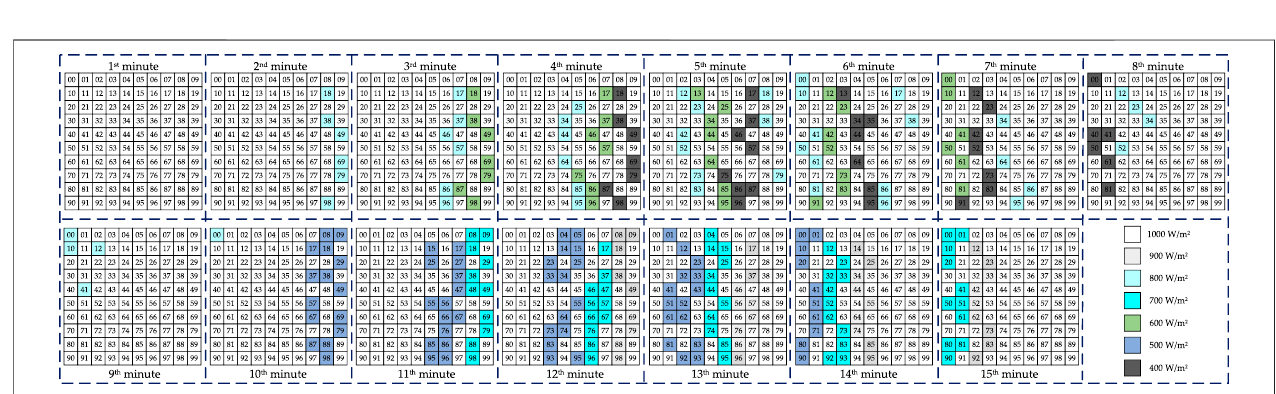
FIGURE 7 | The irradiation distribution for each sub-system based on the compromise solution.